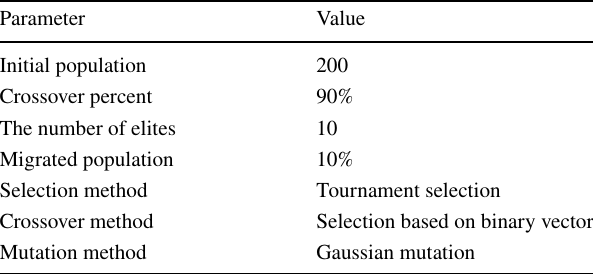
Table 1 Genetic algorithm control and behavioral parameters applied